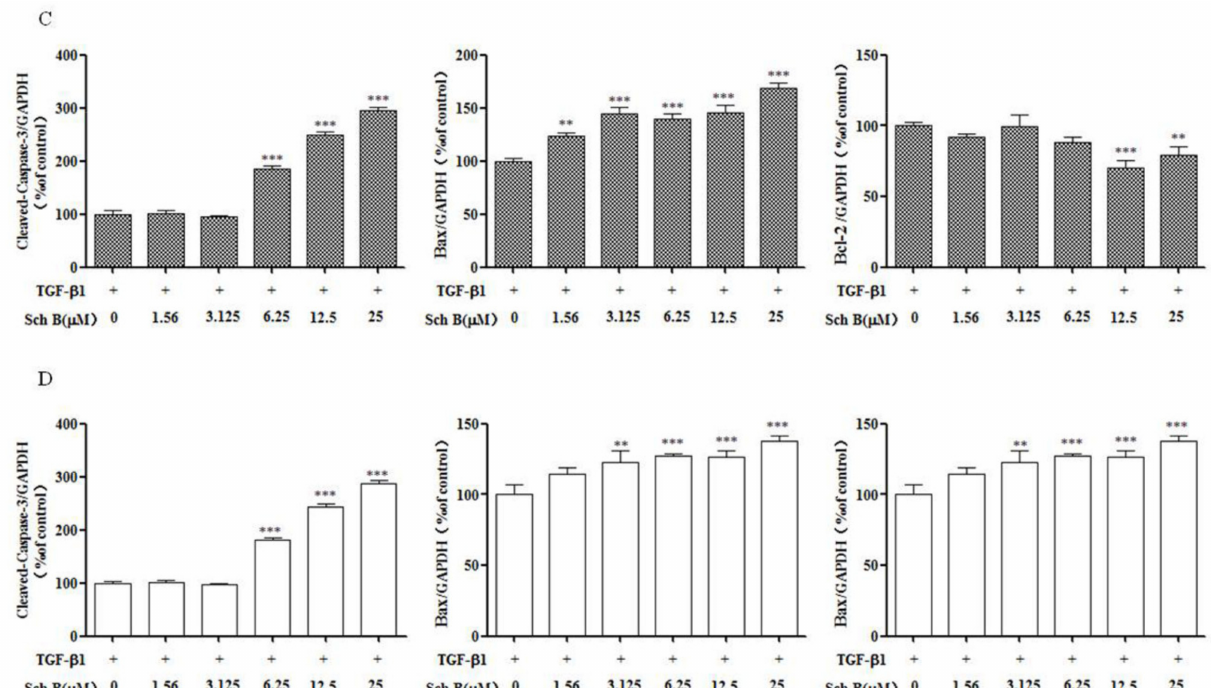
Figure 5. Effects of Sch B on hepatic stellate cells apoptosis factors. The expression of Bcl-2, Bax, and Caspase-3 of HSC-T6 ( A ) and LX-2 ( B ) were determined by western blots. ( C ) Densitometric analysis of cleaved-Cas3, Bax and Bcl-2 of HSC-T6 cells. ( D ) Densitometric analysis of cleaved-Cas3, Bax and Bcl-2 of LX-2 cells. The protein density of bands in western blots were detected using Bio-Rad Quantity One software. Data are presented as means ± SD, ** p < 0.01, *** p < 0.001 compared with the TGF- β 1